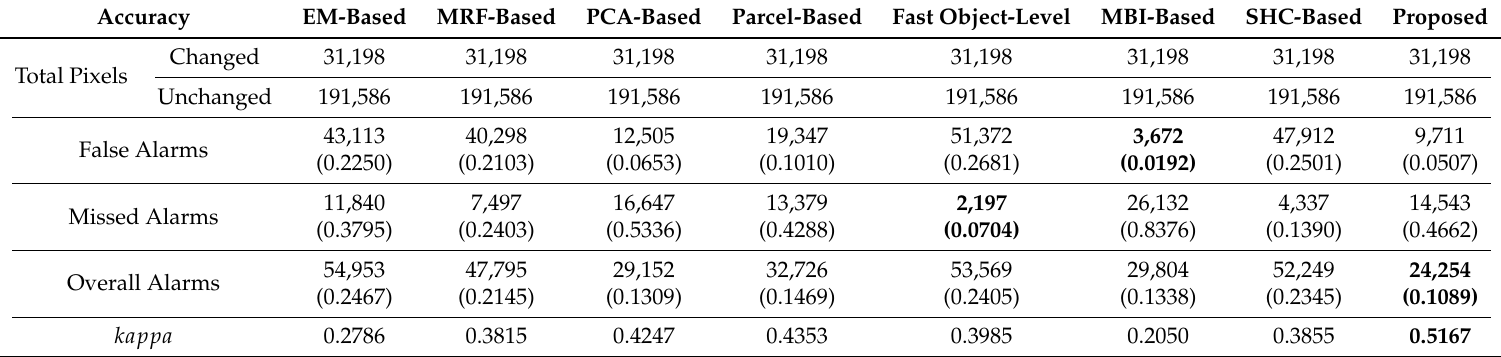
Table 1. Performance comparisons against different approaches on the first set of image pairs.